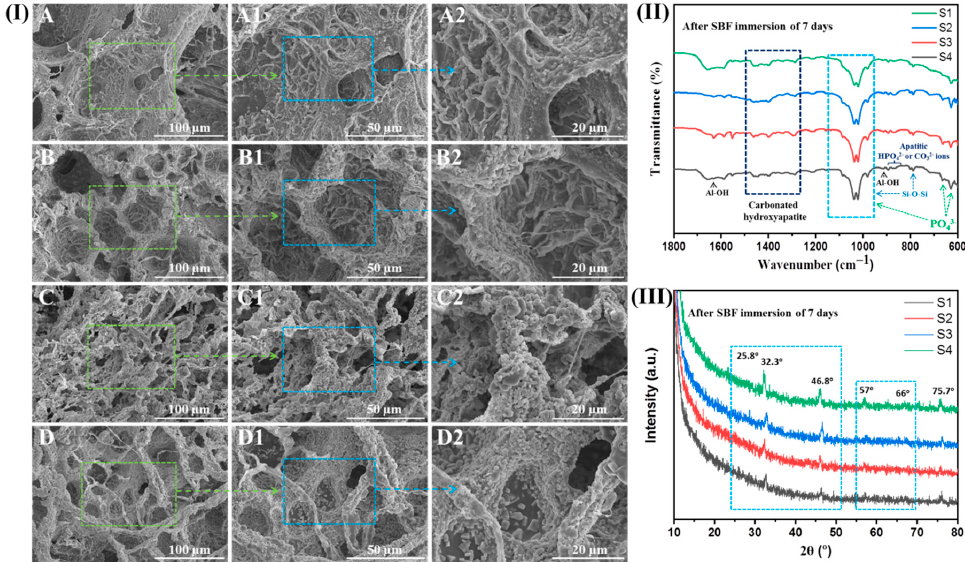
Figure 5. ( I ) SEM images of bone-like apatite formation on the surface of hybrid hydrogels after 7 days of SBF incubation: ( A – A2 ) S1, ( B – B2 ) S2, ( C – C2 ) S3, and ( D – D2 ) S4 hybrid hydrogels. ( II ) FTIR spectra and ( III ) XRD patterns of SBF-immersed hybrid hydrogels after 7 days of incubation.